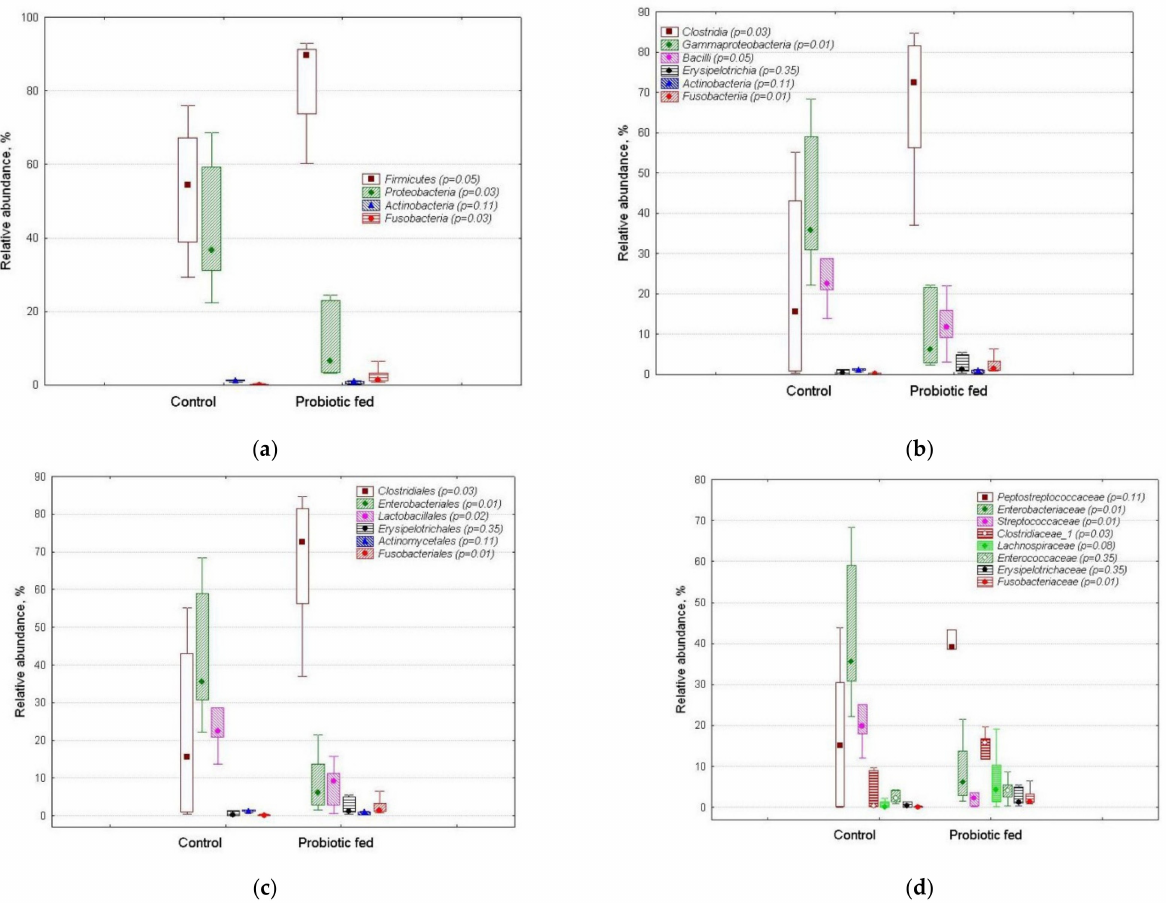
Figure 2. Relative abundance of taxon-specific sequences in fecal bacterial assemblages of ducks of the control and probiotic- fed groups: ( a ) phylum, ( b ) class, ( c ) order and ( d ) family levels. The markers show median, boxes show 25–75% percentiles, while the lines indicate fluctuation ranges. The p -values as estimated for each taxon by Mann–Whitney test are shown in brackets.